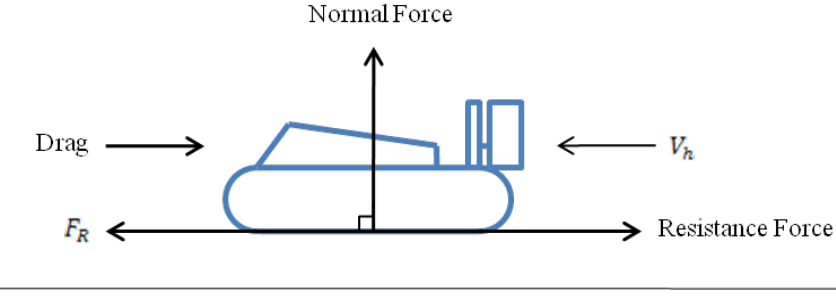
Figure 3. Forces acting on the